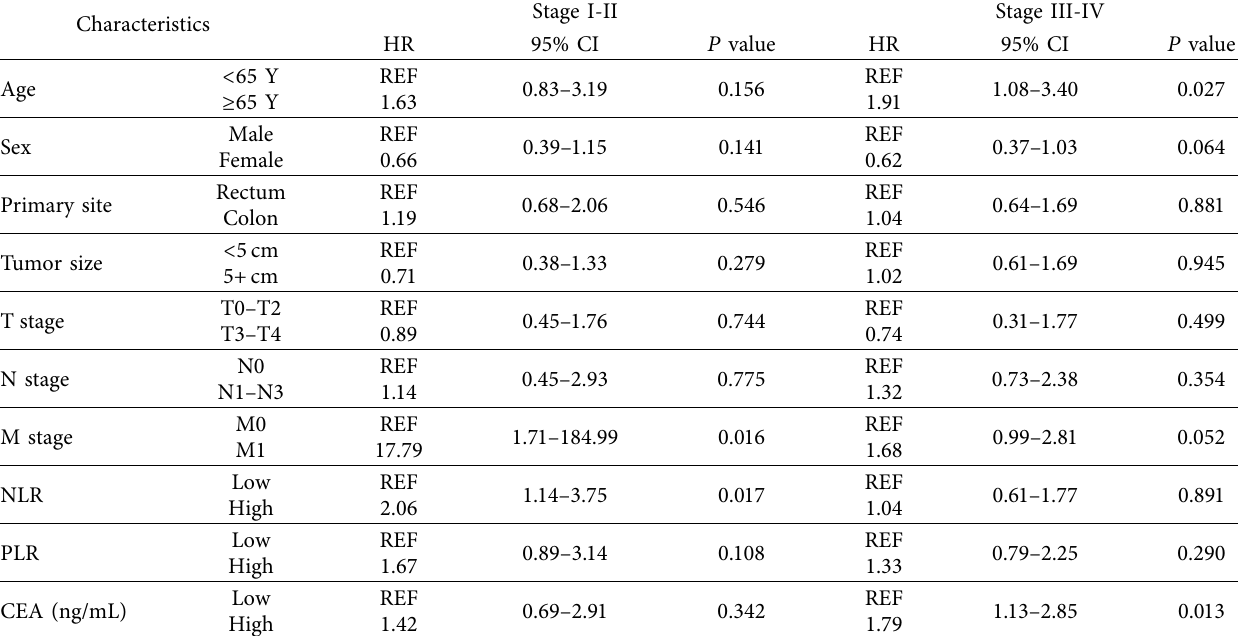
Table 6: Multivariate analysis of overall survival by the clinical pathological